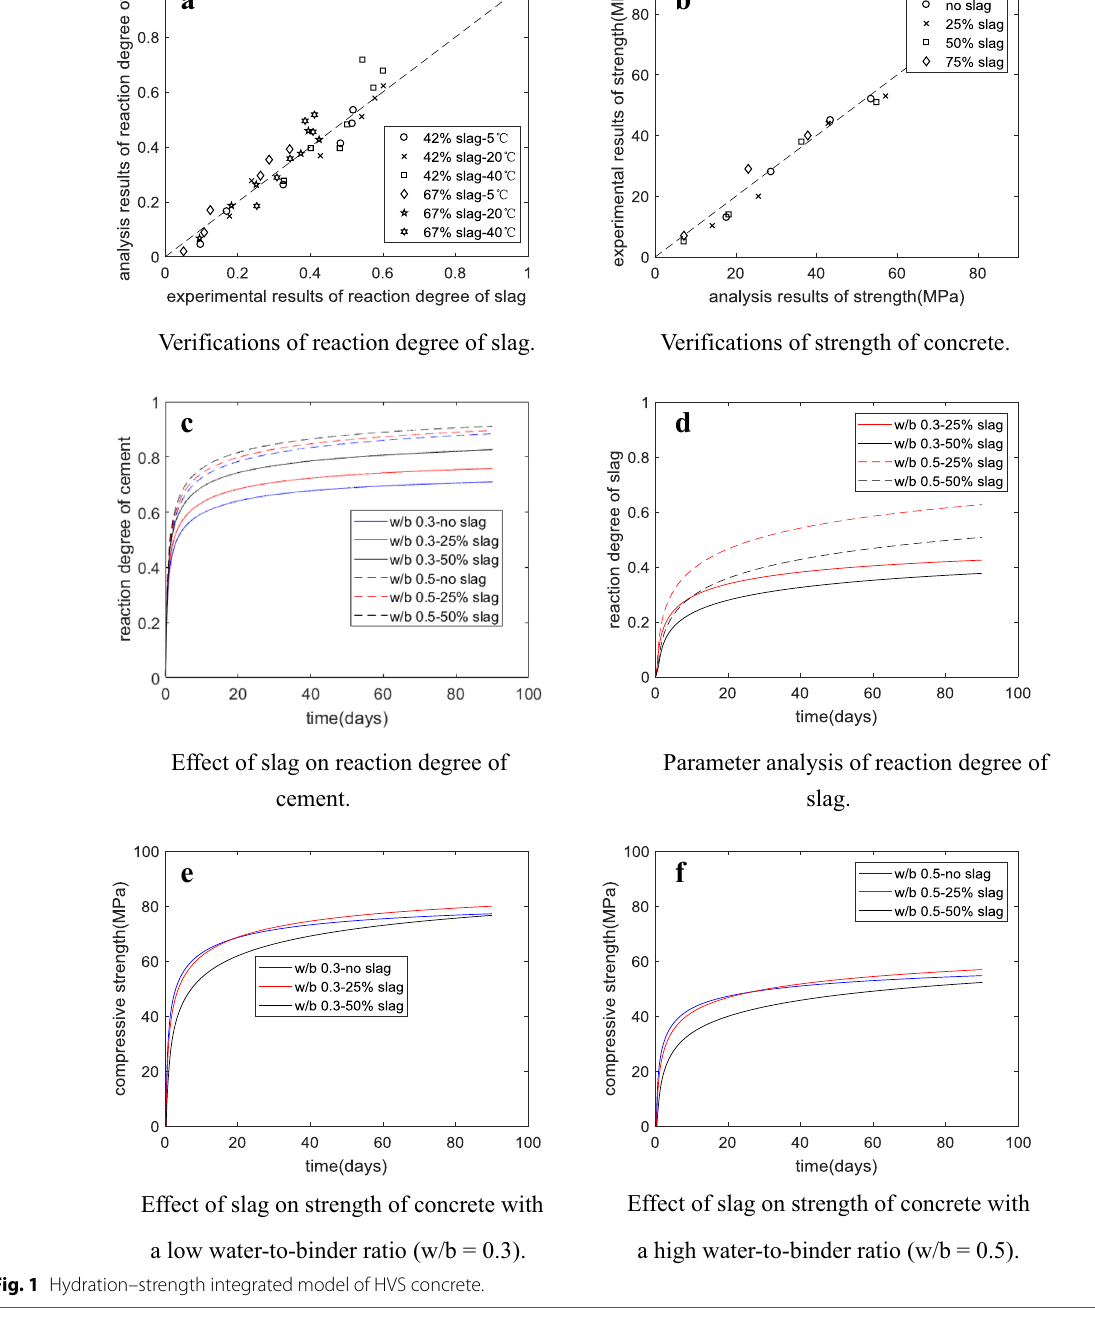
diffusivity are dependent on time. The time-averaged t t 0 [CO 2 ] t dt 0 [ D ] t dt CO 2 concentration t and CO 2 diffusivity t (cid:31) (cid:31) were used for climate change conditions (Lee and Wang 2016; Papadakis 2000).